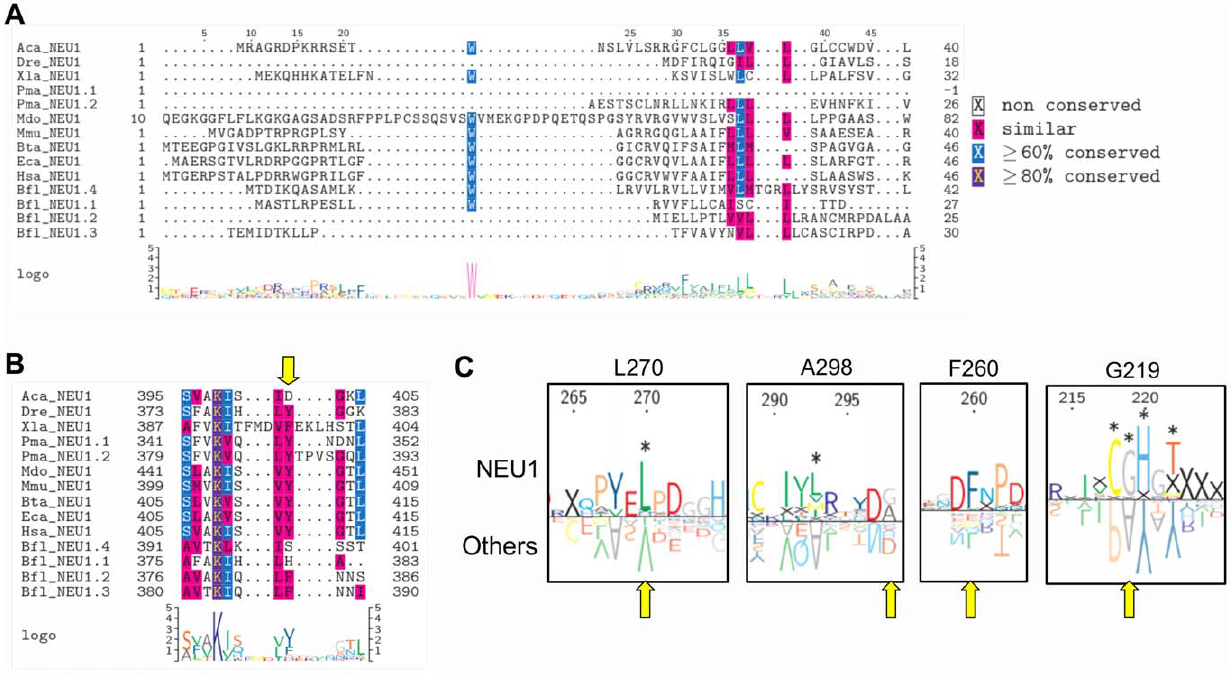
Figure 5. Analysis of NEU1 specific features. Multiple alignment of NEU1 protein sequences revealed that the signal peptide present at the N- terminal in the mammalian enzymes is poorly conserved in vertebrates (A), while the lysosomal localization signal at C-terminus is still present throughout Chordata (B). The conserved aromatic residue, usually placed at 2 4 position, is indicated by the yellow arrow in (B). (C) LOGO representation of the 4 residues essential for the interaction between NEU1 and PPCA. These residues are highly conserved in the NEU1 subgroup but they are lost in other sialidases. Residue numbering is according to human NEU1 sequence. doi:10.1371/journal.pone.0044193.g005 mammals corresponds with the appearance of NEU2 in the sialidase family.